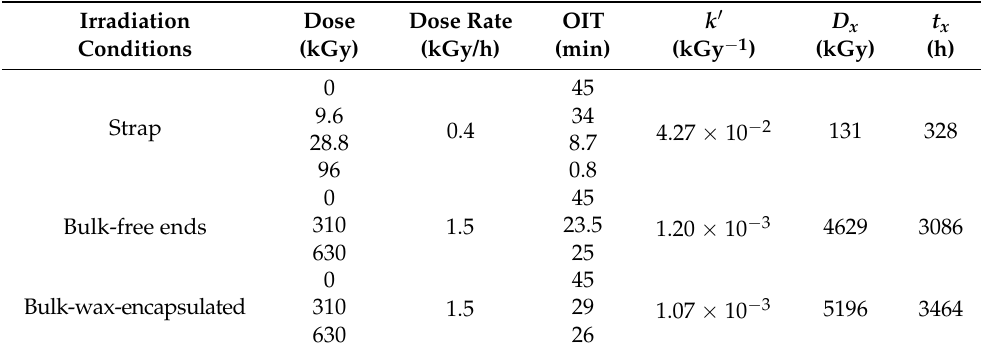
Table 1. Degradation model parameters and lifetime evaluation of LDPE insulation of C1 cable (isothermal DSC measurements, T = 190 ◦ C, air).